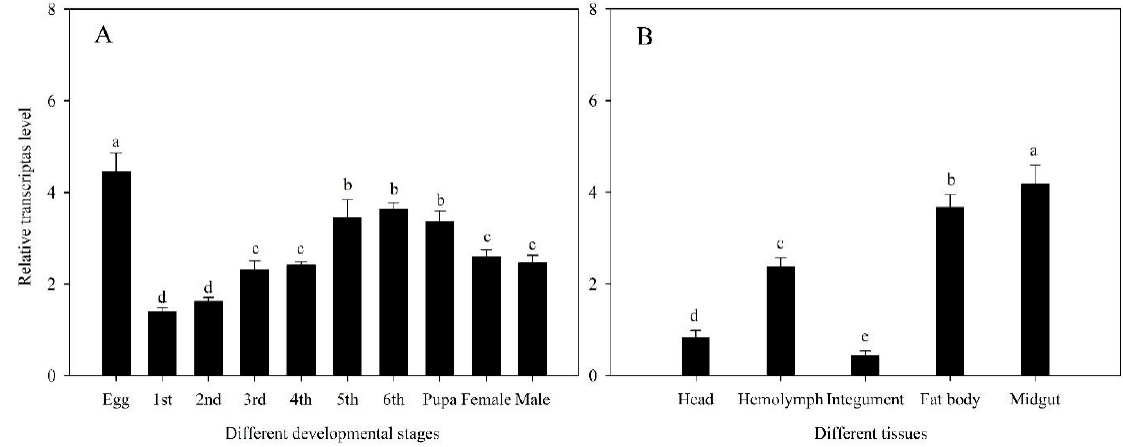
Figure 2. Relative transcript levels of HiACP at different developmental stages and in different tissues. ( A ): Relative transcript level of HiACP at different developmental stages. Lowercase letters (a–d) represent significant differences ( p < 0.05) according to Tukey’s multiple range test. ( B ): Relative transcript levels of HiACP in different tissues. Lowercase letters (a–e) represent significant differences ( p < 0.05) using Tukey’s multiple range test. The relative transcript levels of HiACP in different developmental stages and different tissues were detected by qRT-PCR (Using β -actin as the reference housekeeping gene). The Y-axis values are mean ± SE of relative expression levels. Different lowercase le tt ers on the bars indicate a signi fi cant di ff erence between the treatments.